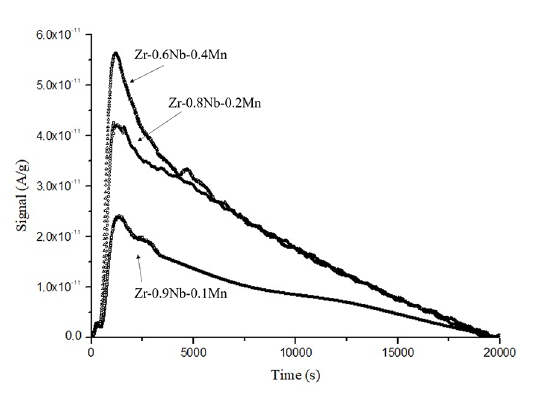
Figure 6. TDS spectra of the hydrogenated Zr-0.9Nb-0.1Mn, Zr-0.8Nb-0.2Mn and Zr-0.6Nb-0.4Mn alloys under annealed condition.